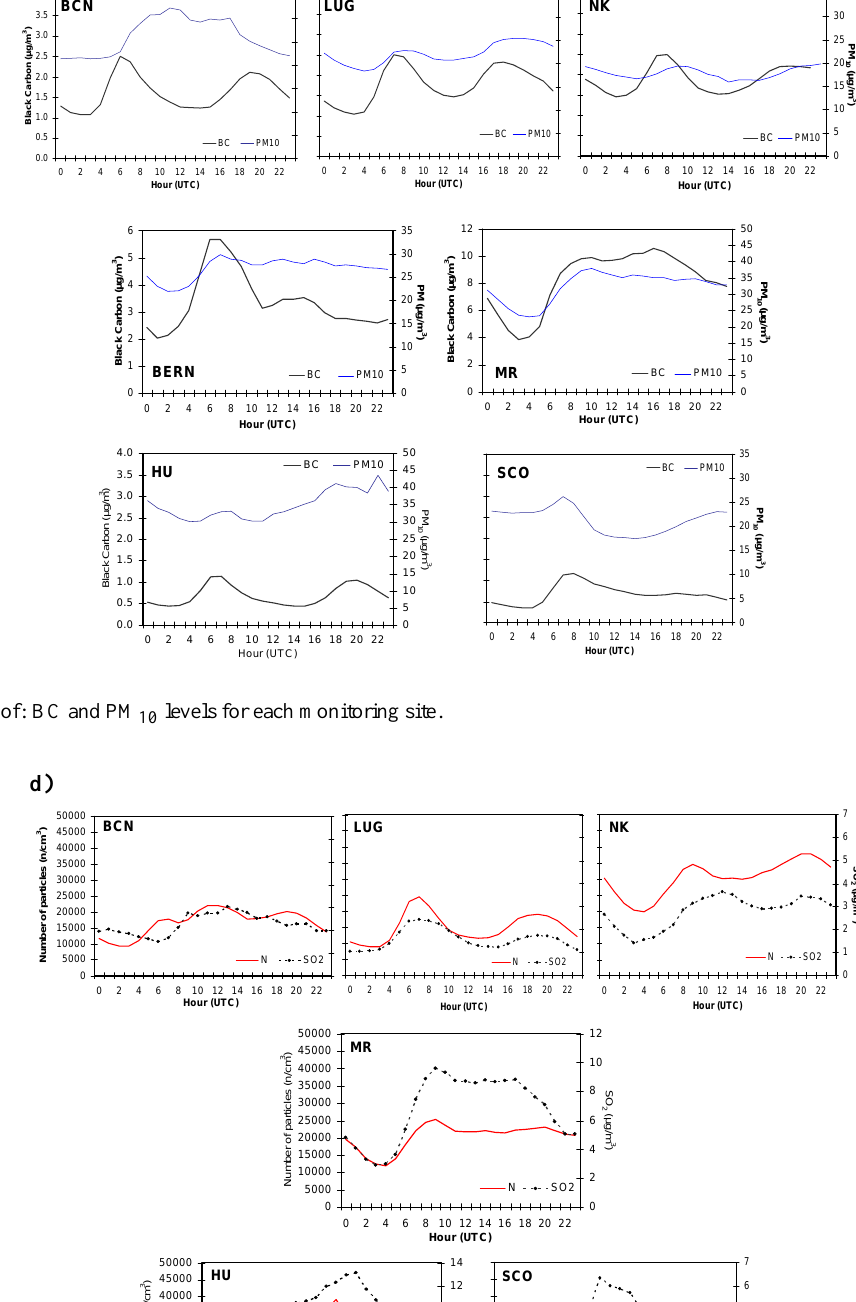
Fig. 2d. Daily cycle of: SO 2 levels for each monitoring